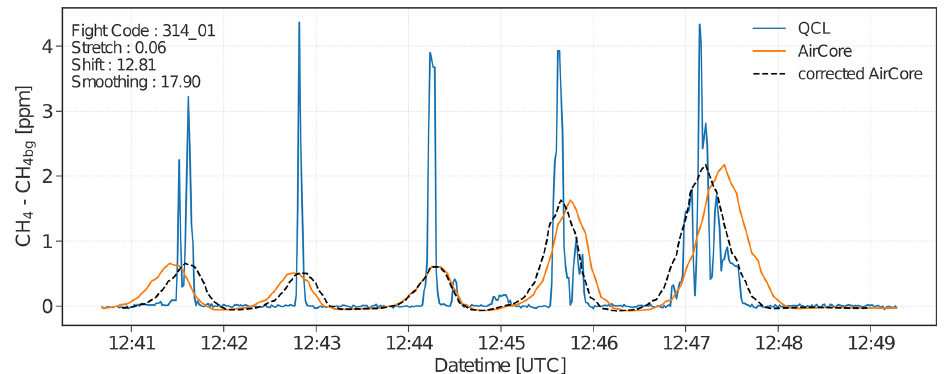
Figure 4. Methane mole fraction time series obtained by simultaneously flying the active AirCore system (orange line) and the in situ QCLAS analyser (blue line). The dashed black line represents the corrected AirCore measurements using the shifting and stretching parameters obtained from the 3S